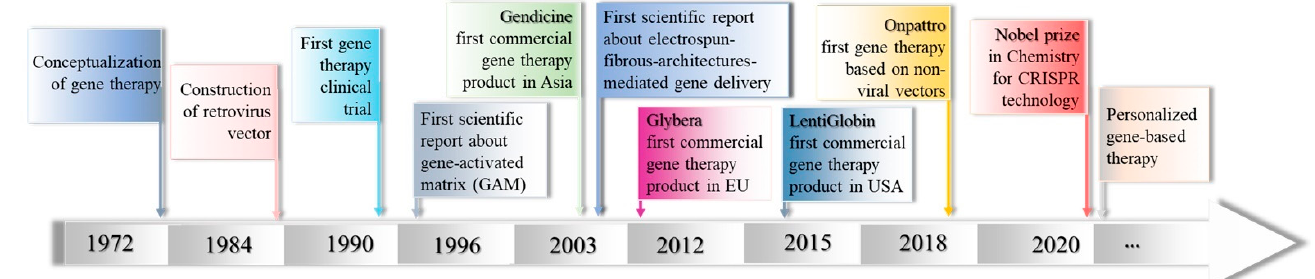
Figure 4. Timeline overview of key events for gene ‐ based therapy.